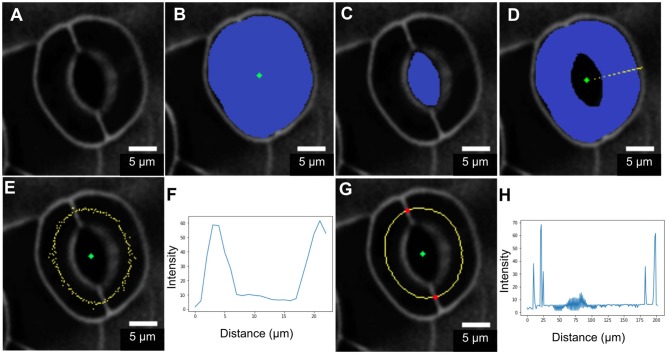
Procedure for measuring guard cell arc length. (A) Original image. (B) Segmentation of the stomatal complex via active contours. (C) Pore area segmentation via active contours. (D) Cell pair area extraction through a binary morphological operation (XOR). (E,F) Non-smooth midline (yellow) calculated between outer cell boundaries and pore boundaries. Intensity profile analysis is in the radial direction. (G,H) Mid-points after smoothing and edge-filling. Junction point detection (red) via intensity profile analysis along the midline.